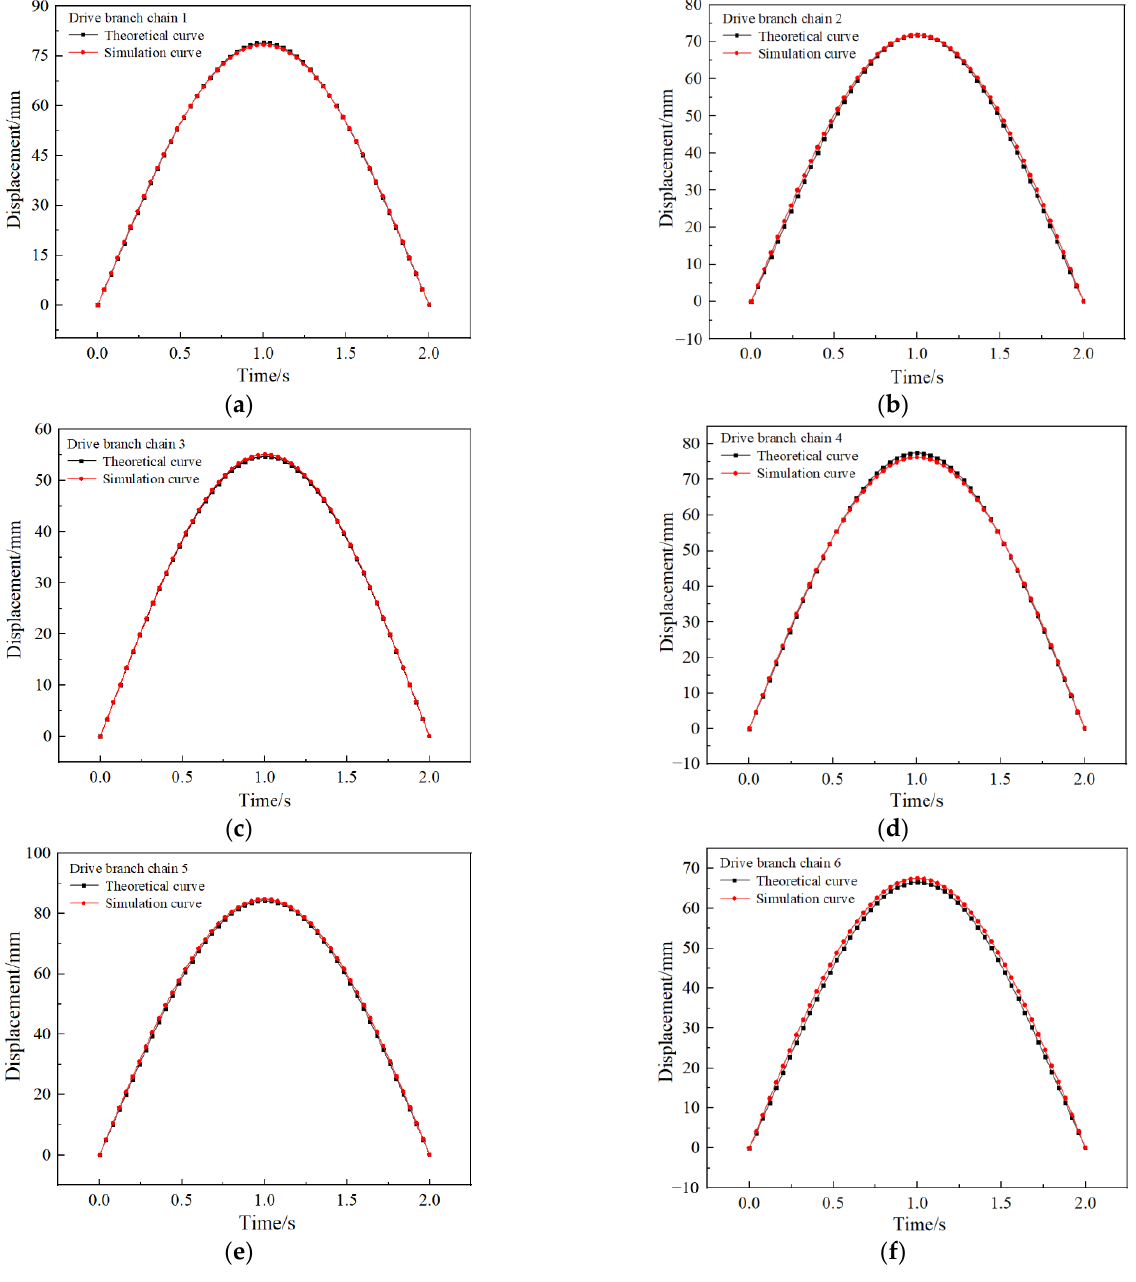
Figure 5. Theoretical verification results of the drive branch chain: ( a ) Drive branch chain 1; ( b ) Drive branch chain 2; ( c ) Drive branch chain 3; ( d ) Drive branch chain 4; ( e ) Drive branch chain 5; ( f ) Drive branch chain 6.